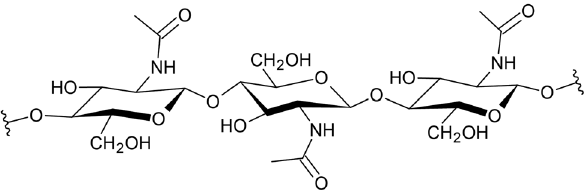
Figure 2: Structure of chitin.